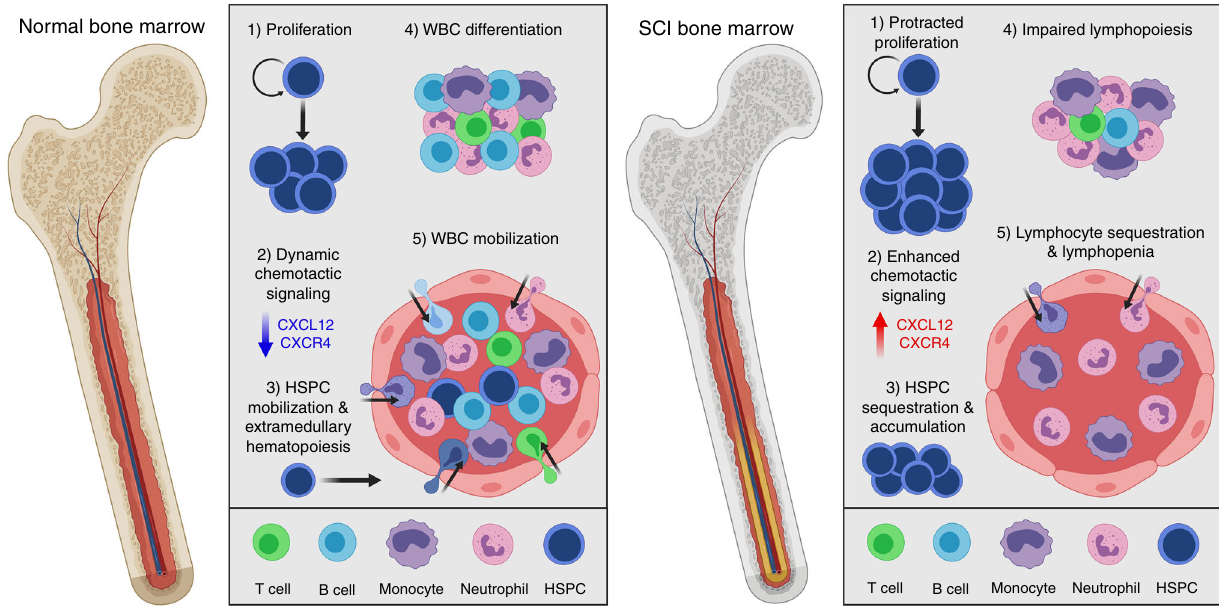
Fig. 9 Summary of the effects of T3 transection SCI on bone marrow hematopoiesis. Under homeostatic conditions, HSPCs undergo highly regulated and short-lived proliferation (1). When demand dictates (i.e. stress, trauma, infection), normal bone marrow downregulates CXCL12-CXCR4 signaling (2), allowing HSPC mobilization and extramedullary hematopoiesis (3). Homeostatic bone marrow also allows for the coordinated differentiation (4) and mobilization (5) of all leukocyte lineages, maintaining normal circulating blood leukocyte levels. T3 transection SCI, however, causes chronic bone marrow failure, including protracted proliferation (1), excessive CXCL12-CXCR4 chemotactic signaling (2), and impaired mobilization leading to the accumulation of HSPCs within the bone marrow and loss of extramedullary hematopoiesis. T3 transection SCI also causes lymphopenia by reducing lymphopoiesis (4) and sequestering mature lymphocytes in bone marrow